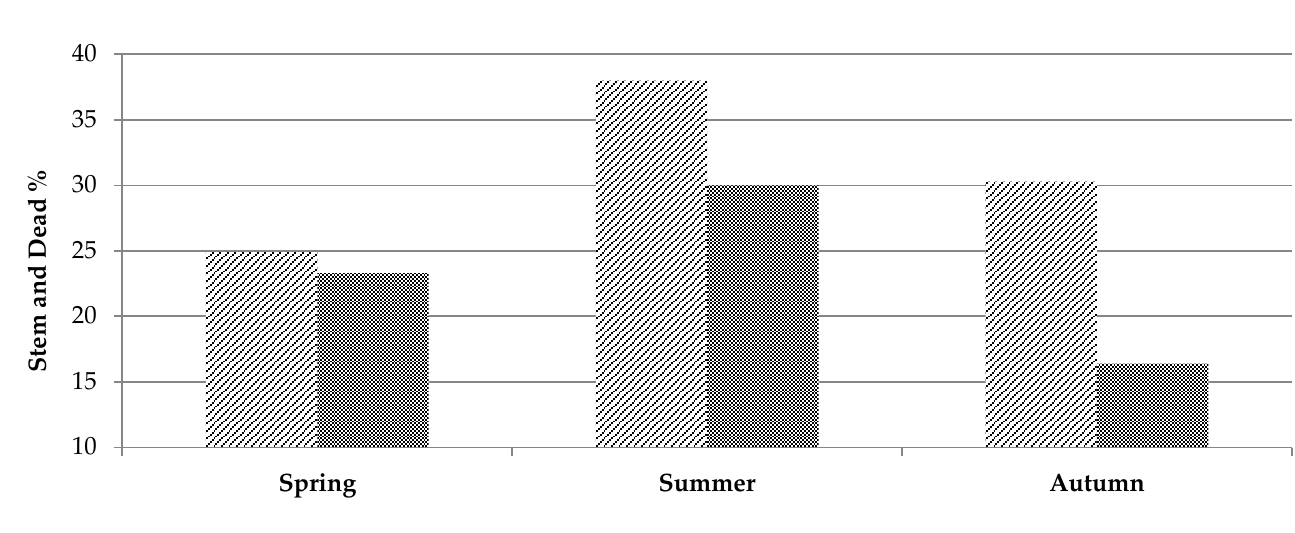
Figure 1. Combined stem and dead proportion of grass-only and grass-white clover swards offered to individually housed sheep in spring (27 March – 29 April),